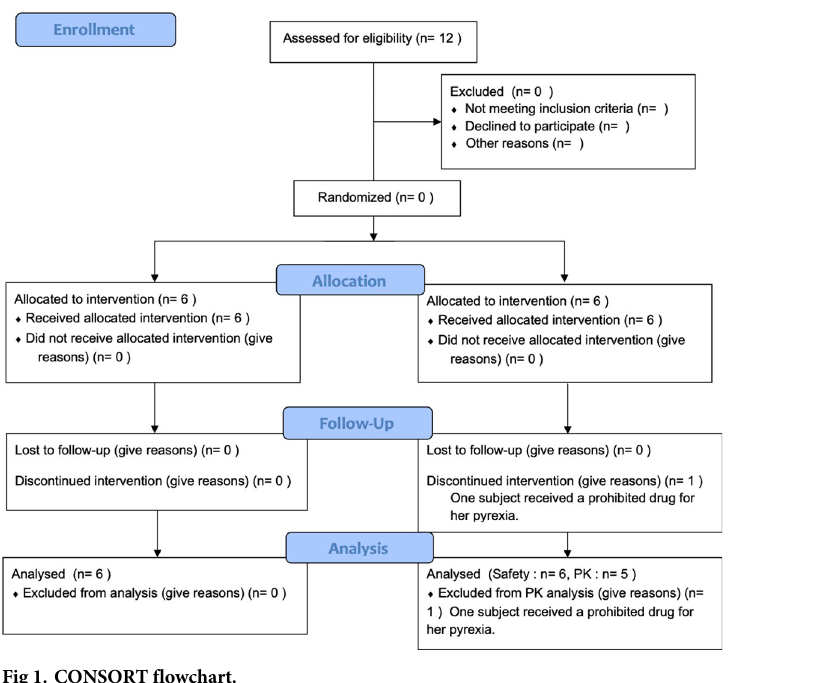
Fig 1. CONSORT flowchart.